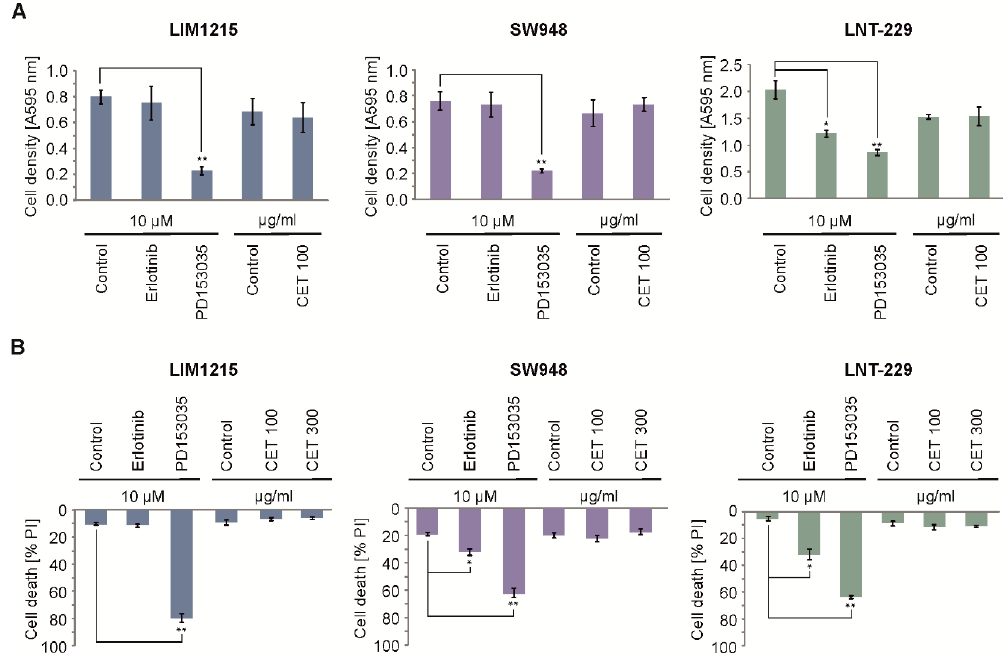
Figure 1. Growth inhibition and toxicity profile of EGFR inhibitors. ( A ) LIM1215, SW948, and LNT-229 cells were incubated with vehicle, 10 µM erlotinib, 10 µM PD153035, or 100 µg/mL cetuximab (CET 100) under normoxia for 48 h in serum-free medium. Cell density was assessed by crystal violet (CV) staining ( n = 3, mean ± SD, * p < 0.05, ** p < 0.01). ( B ) LIM1215, SW948, and LNT-229 cells were incubated as in ( A ) with an additional 300 µg/mL cetuximab (CET 300) condition. Cell death was measured by propidium iodide (PI) uptake ( n = 3, mean ± SD, * p < 0.05, ** p <